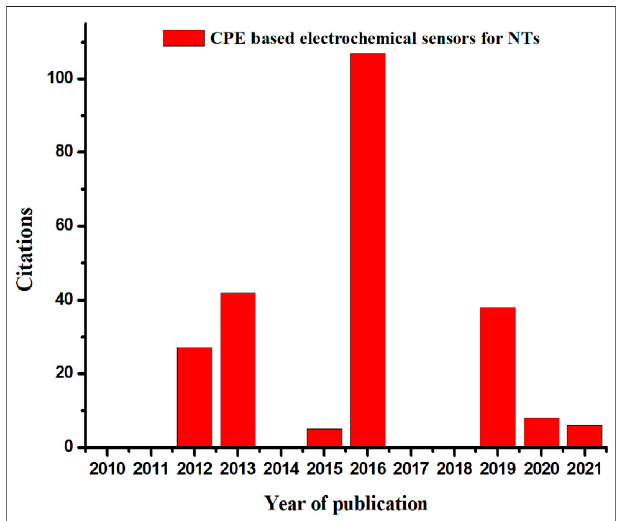
FIGURE 1 | A graph showing the evolution of published work and citations in the fi eld of CPE based electrochemical sensors for NTs.